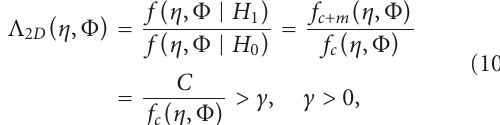
test can be exploited to maximize the P d with constant P fa as where C is a constant and γ is the detection threshold. Equation (10) can be simplified as constant-density contour lines on the magnitude-phase